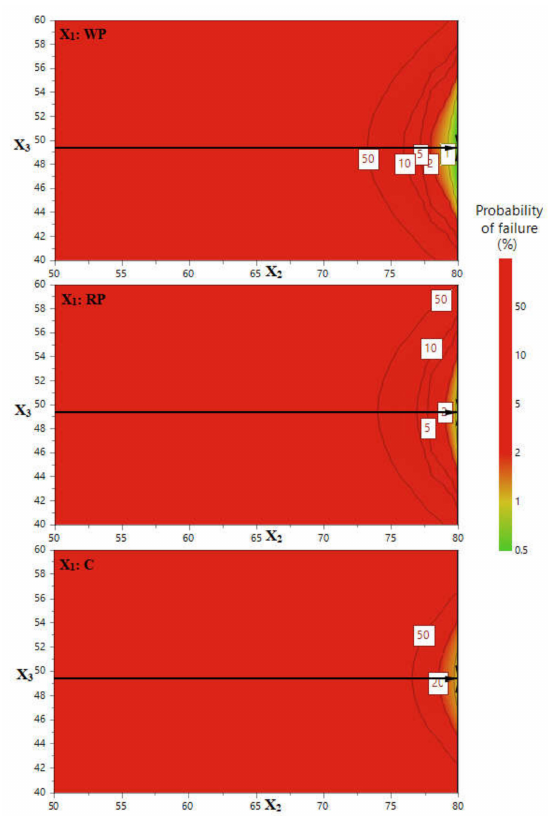
Figure 4. Design spaces describing the conditions necessary to obtain maximum extraction e ffi ciency for the three types of plant material (X 1 ): white pomace (WP), red pomace (RP) and canes (C), with X 2, the ethanol ratio (%) and X 3, the temperature ( ◦